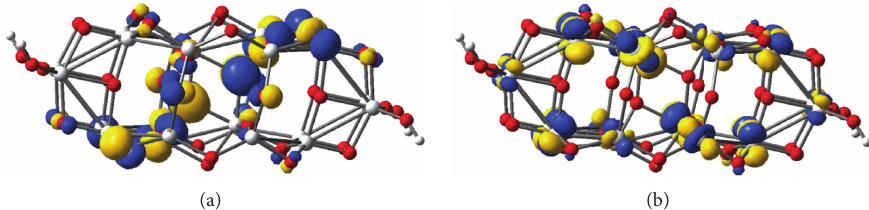
Figure 6: Isodensity surfaces (0.03 e/bohr 3 ) of the key molecular orbitals of the Ti 24 O 50 H 4 cluster, calculated at DFT/B3LYP/DZVP level in water: (a) highest occupied valence band orbital, (b) lowest unoccupied conduction band orbital.